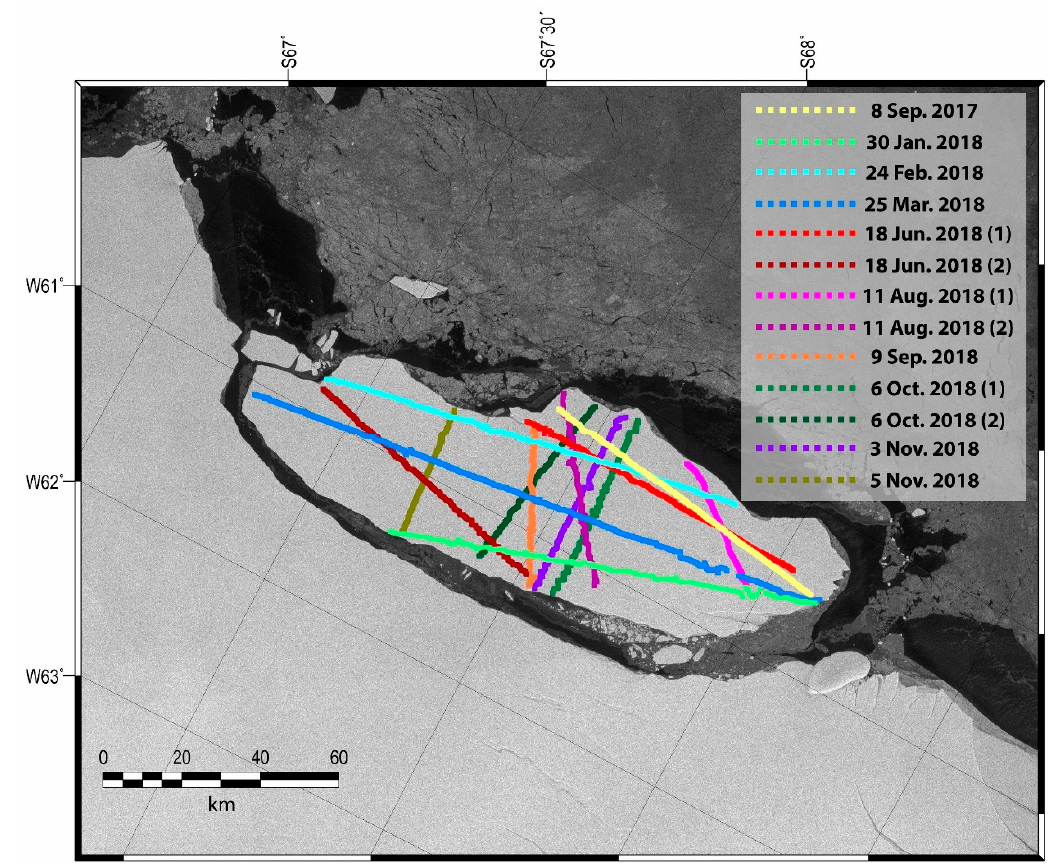
Figure 2. CryoSat-2 SAR Interferometic (SARIn) mode profiles on iceberg A68A overlaid on the Sentinel-1A SAR image acquired on 8 September 2017. The freeboard changes of the iceberg were calculated at the intersections of the different profiles which have a time difference of more than 180 days.